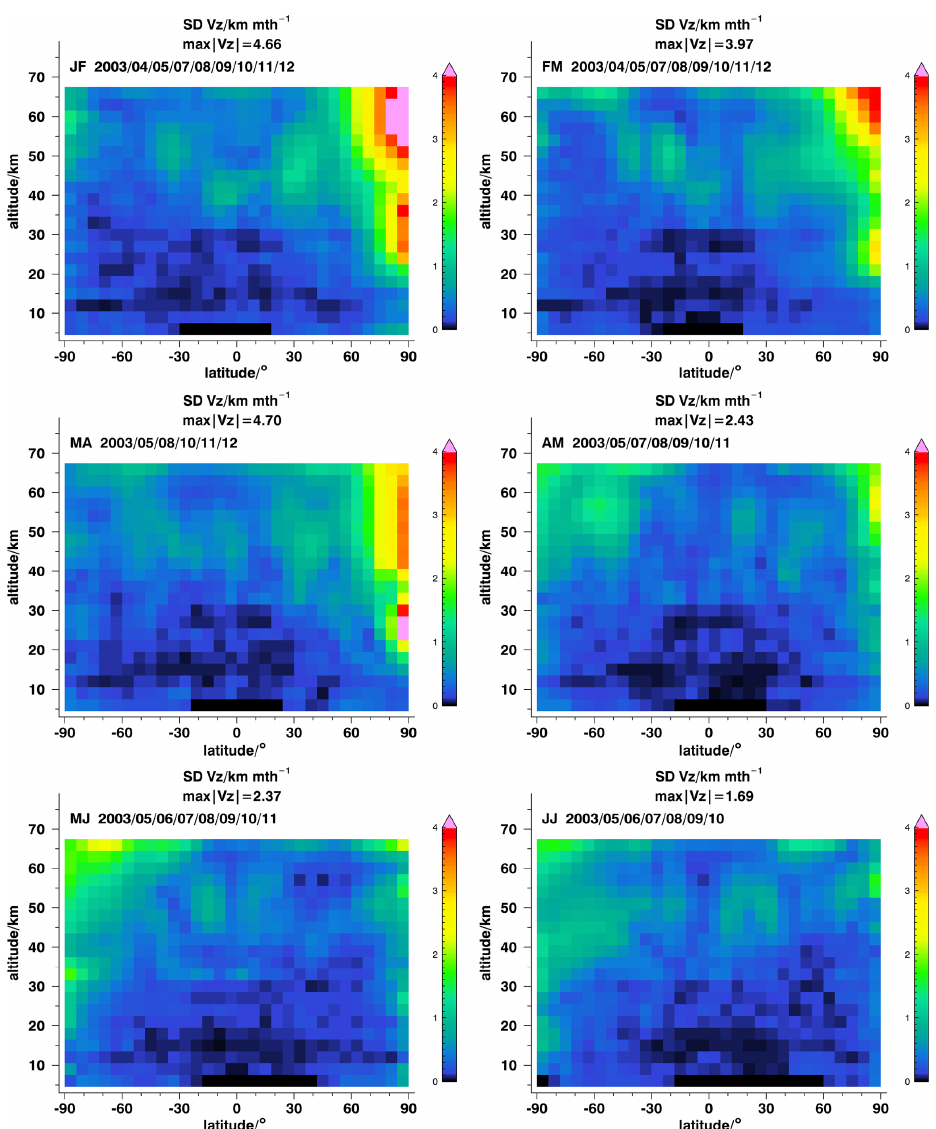
Figure 6. Interannual variability of the middle atmospheric vertical effective velocities in terms of sample standard deviations from January– February (top left, JF) to June–July (bottom right,